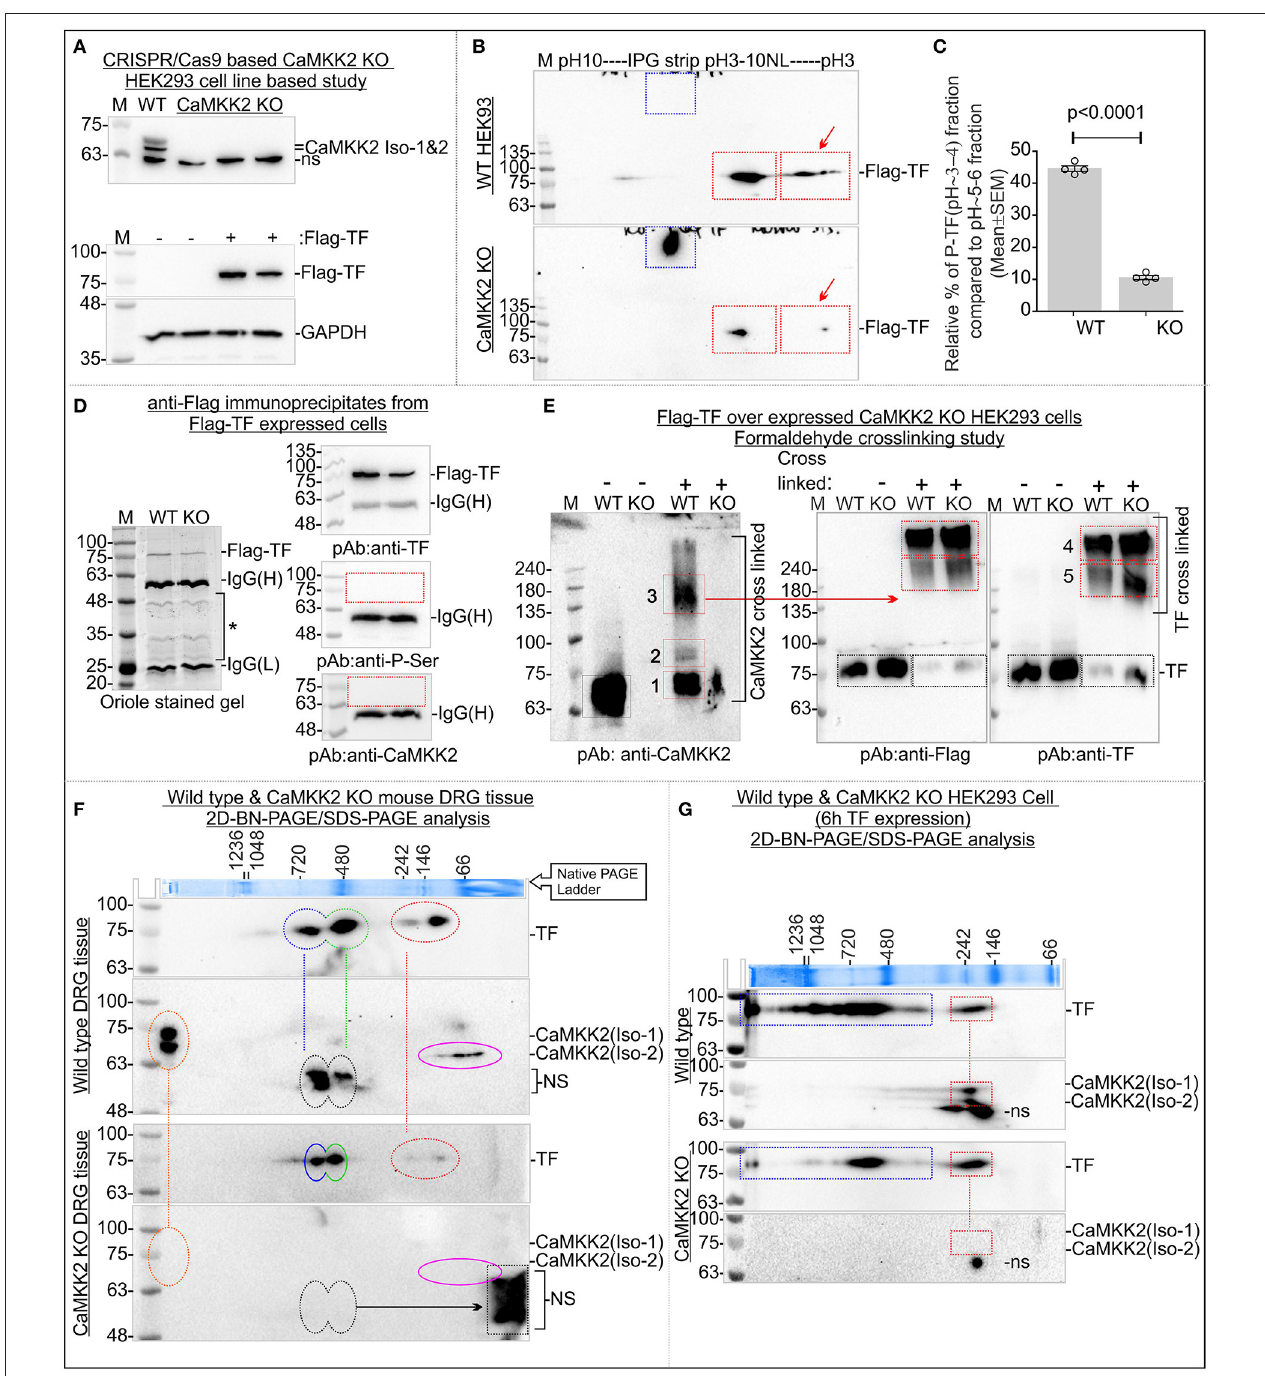
FIGURE 3 | CaMKK2 is not directly associated with TF and loss of CaMKK2 affected TF associated protein complexes. (A) Immunoblot showing expression of CaMKK2 in the wild-type and three CRISPR/Cas9 based CaMKK2 KO HEK293 clonal cell lines selected independently (Top panel). Bottom panel: Flag-TF and GAPDH expression in HEK293 cells. (B) Immunoblots showing charged fractions of Flag-TF in the wild-type and CaMKK2 KO HEK293 cells. The red arrow represents P-TF. Blue square represents HMW TF. (C) Scatter plot showing the relative amount of P-TF. N = 4 from 4 independent experiments. The p -value by t -test (unpaired). (D) Immunoblots showing the presence of the TF and absence of the CaMKK2 in the Flag-TF immunoprecipitated fraction. The same protein fraction was also immunoblotted with the pan-P-ser specific antibody. (E) Immunoblots showing the relative shift of crosslinked CaMKK2 and TF in Flag-TF expressed wild-type and CaMKK2 KO HEK293 cells. The red squares represent the relative shift of the crosslinked proteins. Black Square represents native non-crosslinked form, shifted bands are numbered in Arabic numerals. (F,G) Immunoblots showing TF and CaMKK2 associated MPCs in mouse wild-type and CaMKK2 KO DRG tissues and Flag-TF expressed wild-type and CaMKK2 KO HEK293 cells. Dotted vertical lines indicate vertical alignment of the co-migrated protein complexes. Colored circles indicate MPCs. ns, Non-specific. The Coomassie stained gel strip on the top panel showing native page molecular weight ladder.